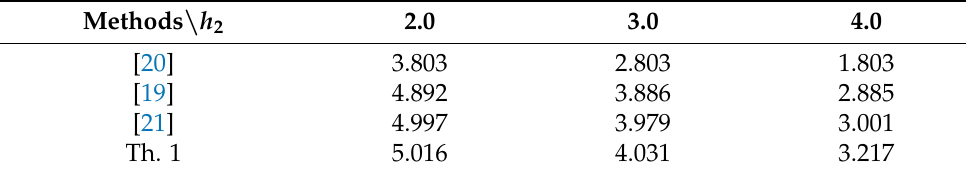
Table 3. MAUBs h 1 for given h 2 , K P and K I under one-area LFC system.